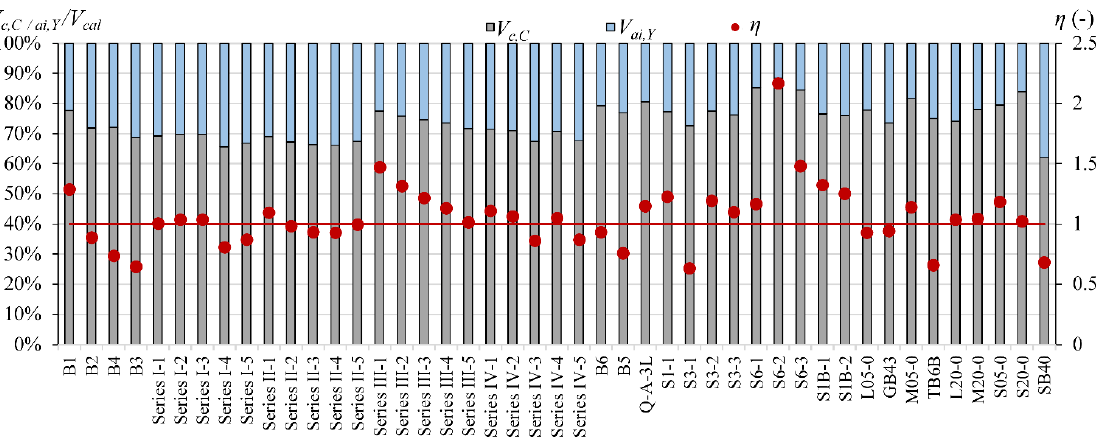
Figure 11. The comparison of shear mechanism contribution for GFRP and steel RC beams with reinforcement ratio ρ l ~ 1.8% for Cladera et al.’s. and Yang’s models.